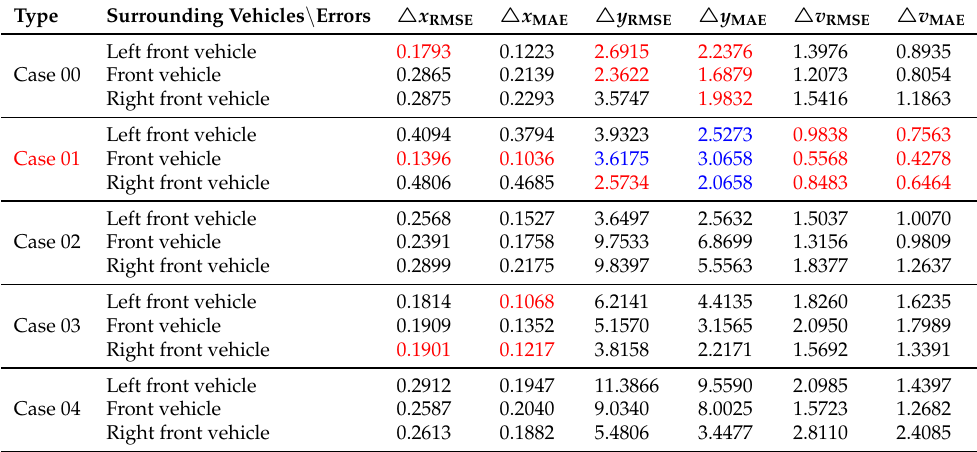
Table 2. Prediction errors for surrounding vehicles based on DBN.